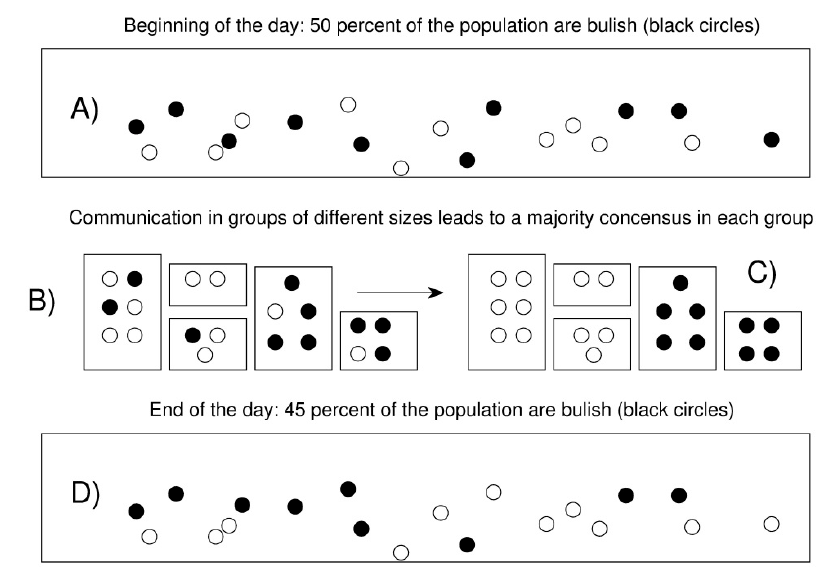
Figure 7. Changing the “bullishness” in a population via communication in subgroups. ( A ) at the beginning of a given day t , a certain percentage B ( t ) are bullish; ( B ) during the day communication takes place in random subgroups of different sizes; ( C ) illustrates the extreme case of complete polarization m k,j = ±1 created by a majority decision. In general, m k,j ≃ j / k corresponds to the neutral case where opinion remains unchanged on average within a subgroup of size k ; ( D ) due to the communication in the different subgroups, the “bullishness” at the end of the day is different from what it was at the beginning of the day. The figure is taken from (Corral et al. 1995).